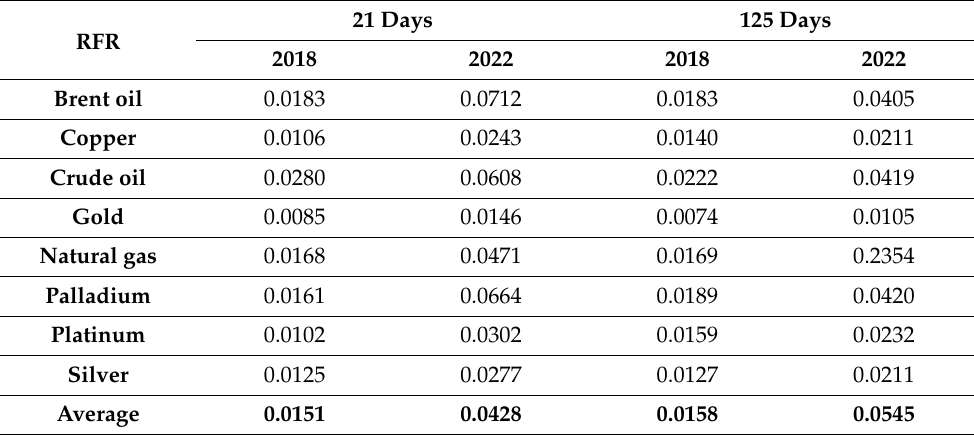
Table 11. Random Forest (RF) forecast results.